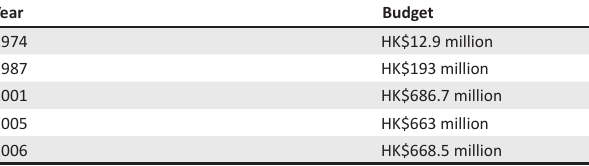
TABLE 3: Hong Kong’s allocation to the Independent Commission Against Corruption (1974–2006).